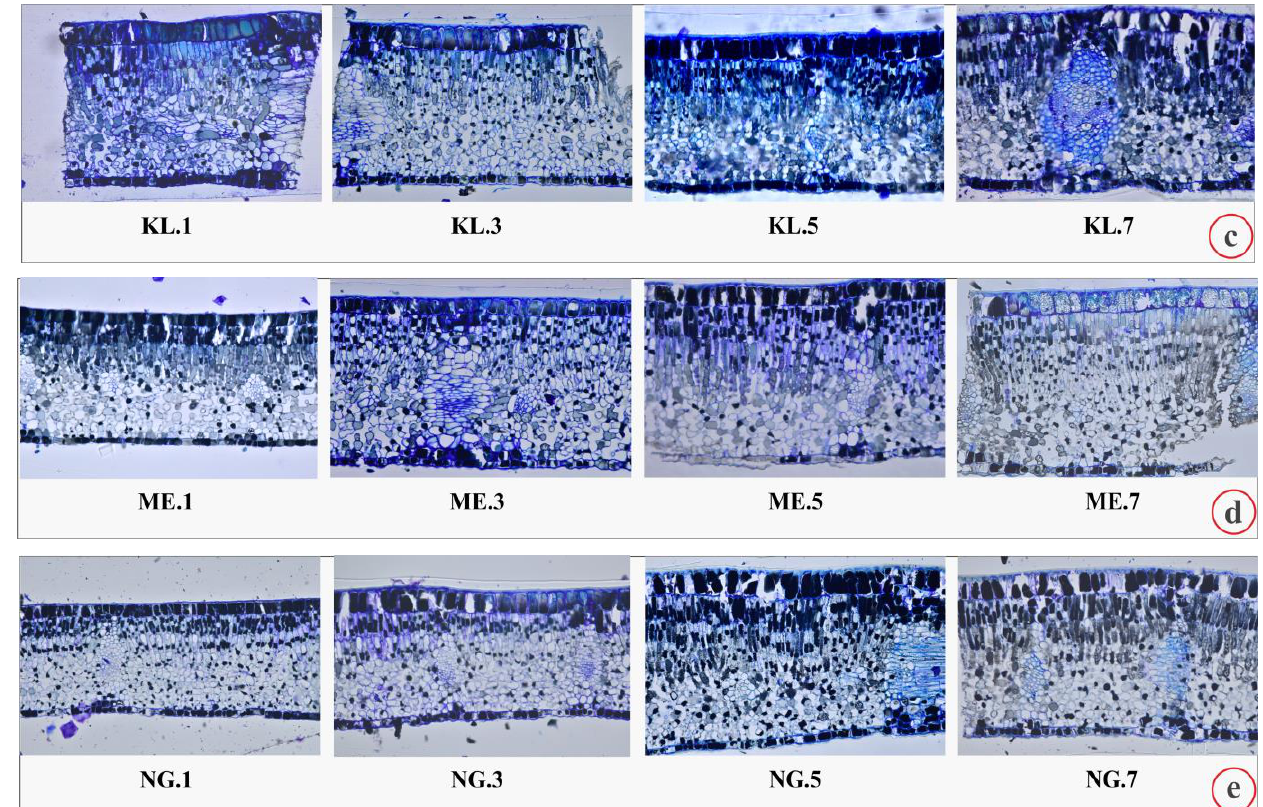
Figure 3. Cross-sections of the successively expanding leaflets of compound leaves of C. siliqua from selected trees and studied sites, that is, from: ( a ) KE (Kessariani aesthetic forest), ( b ), PF (Paleo Faliro), ( c ) KL (Klafthmonos square), ( d ) ME (Metaxourgeio) and ( e ) NG (National Garden); also, for capital initials see Table 1. KE.1, PF.1, KL.1, ME.1 and NG.1 correspond to cross-sections of the